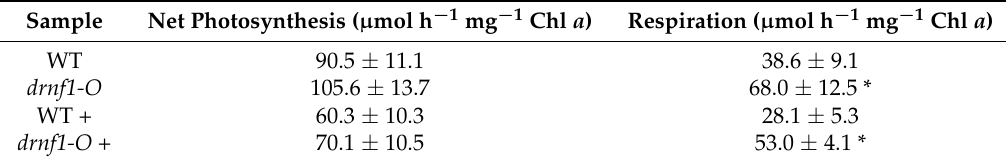
Table 1. Net photosynthesis and respiration of WT and drnf1 -O Synechocystis strains before and after salt stress measured by O 2